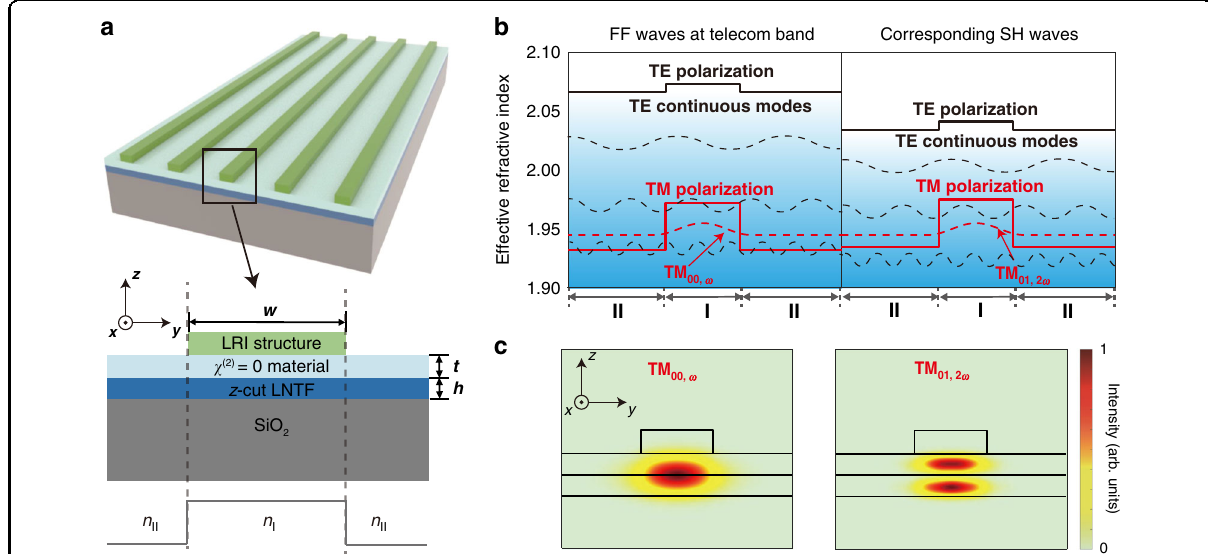
Fig. 1 Design of BIC-based etchless semi-nonlinear photonic waveguides. a 3D schematic of the BIC-based semi-nonlinear photonic waveguide with the corresponding y - z cross section. The waveguide consists of a z -cut LNTF with a thickness of h on a SiO 2 substrate, a zero- χ (2) material with a thickness of t and a LRI waveguide with a width of w on top. The nonlinear waveguide could be seen as a “ three-layers ” slab waveguide along y axis with equivalent refractive indices of n II, n I and n II from left to right. b Effective one-dimensional refractive index along y -direction in the corresponding regions of I and II of the waveguide working at the FF and corresponding SH wavelengths. The bound FF TM 00 and SH TM 01 modes are engineered to share the same modal refractive index. c Mode pro fi les of the FF TM 00 and SH TM 01 bound modes that meet the MPM